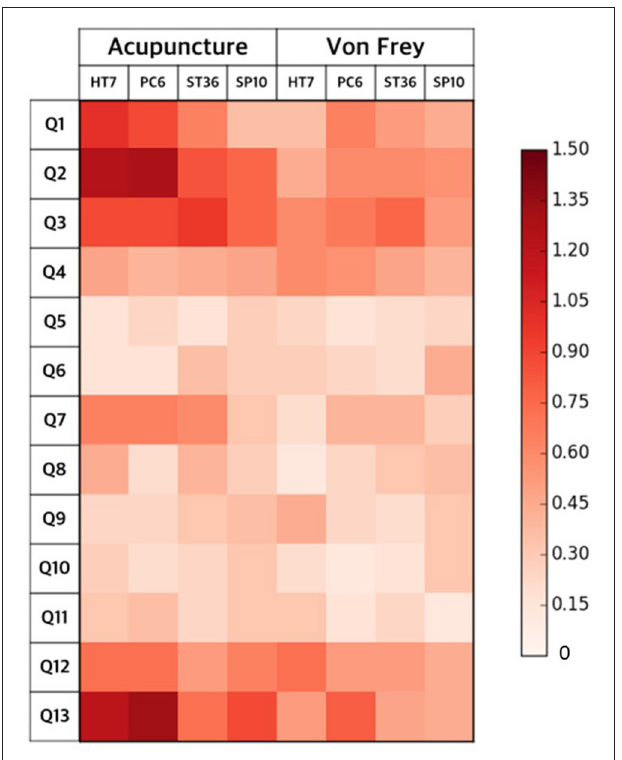
FIGURE 2 | DeQi intensities of the two types of stimulation at four acupoints. The single items were Q1, dull; Q2, numb; Q3, spreading; Q4, warm; Q5, relief of tense or tight muscles; Q6, gentle (soft) touch; Q7, heavy; Q8, compressing or pressing; Q9, refreshing or relieving; Q10, activated digestion with bowel motion; Q11, streaming opening flow of a previously stuffed or blocked feeling; Q12, activated circulation; and Q13, pricking. Overall, we found that the DeQi sensations following acupuncture stimulation were more intense than those following tactile stimulation, with small differences among the four different